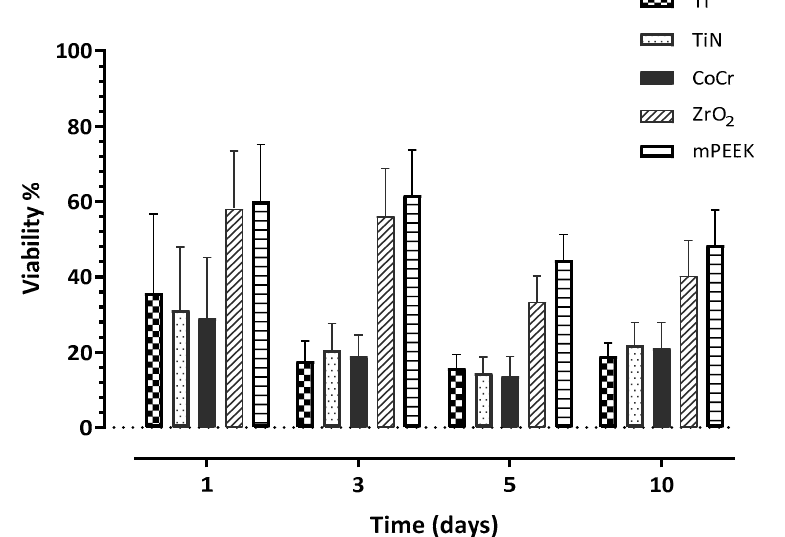
Table 3. The mean and standard deviation values of cell proliferation percentage at days 1, 3, 5, and 10 (HGFB). Values with the same superscript letters represents a non-significant difference (Tukey’s post hoc ( p > 0.05)) between the investigated materials at each time point. Figure 5. A bar chart illustrating the mean values of cell proliferation (viability) percentage at days 1, 3, 5, and 10 for HGFB. Error bars represent the standard deviation. ( p < 0.0001) and nonsignificant